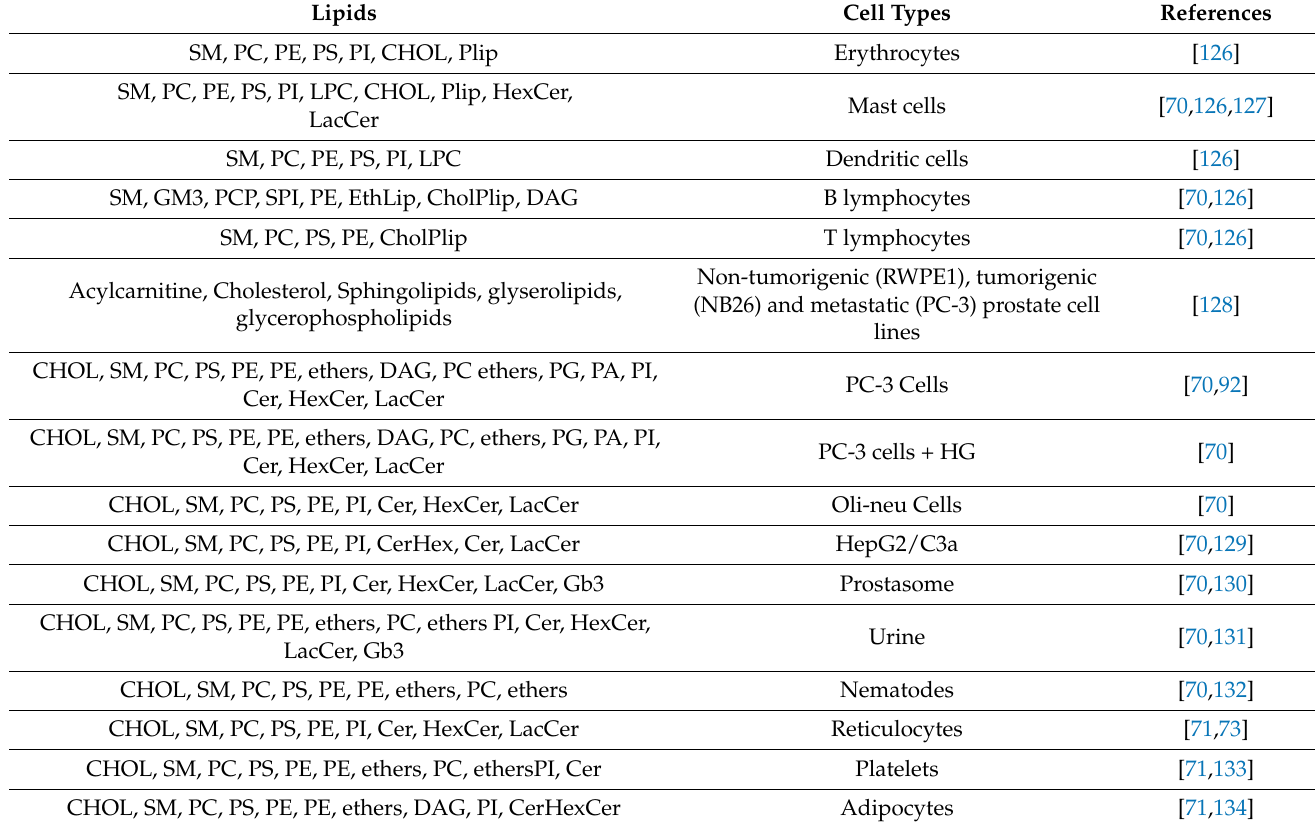
Table 4. Lipid families identified in exosomes released from various cell types.